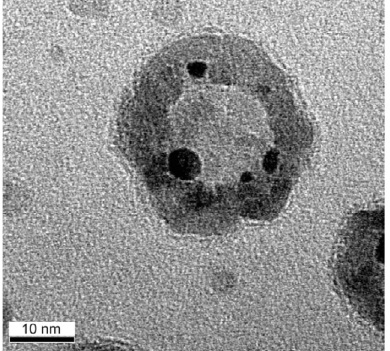
O particle. Reproduced with permission from 3 4